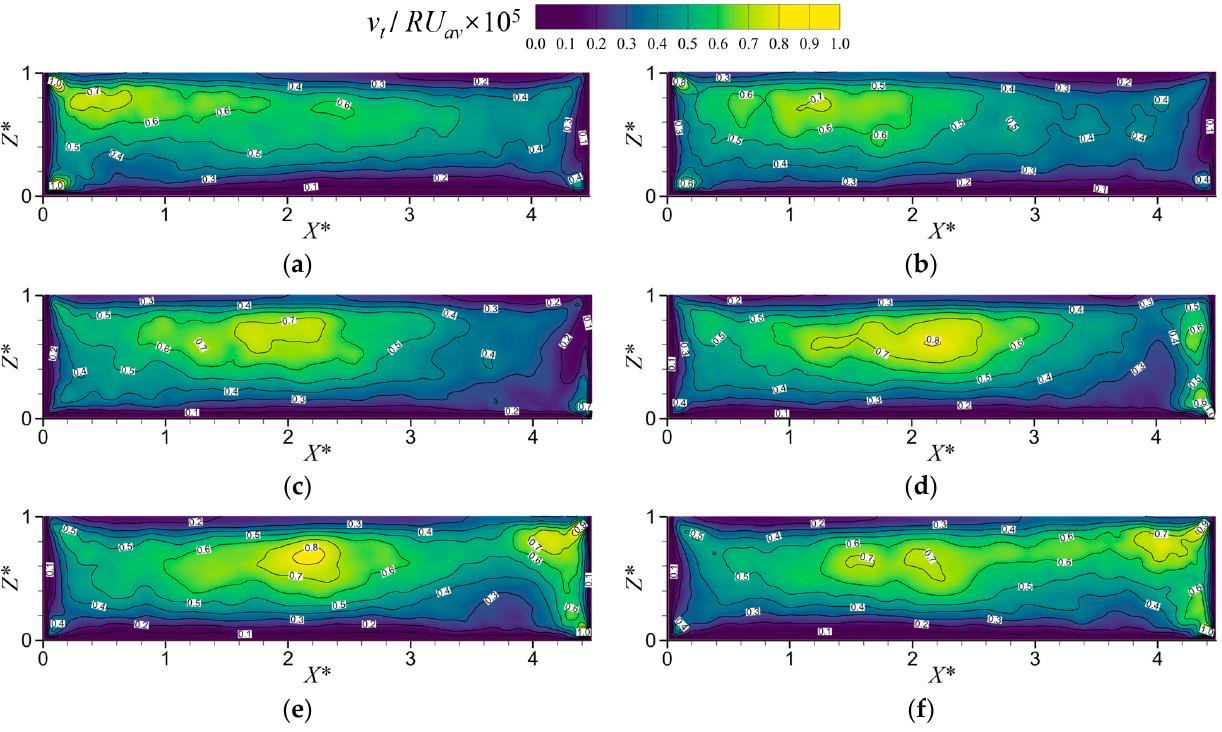
Figure 10. The contours and isolines of turbulent viscosity. (From left to right denotes from inner bank to outer bank). ( a ) Section#01; ( b ) Section#02; ( c ) Section#03; ( d ) Section#04; ( e ) Section#05; ( f ) Section#06.